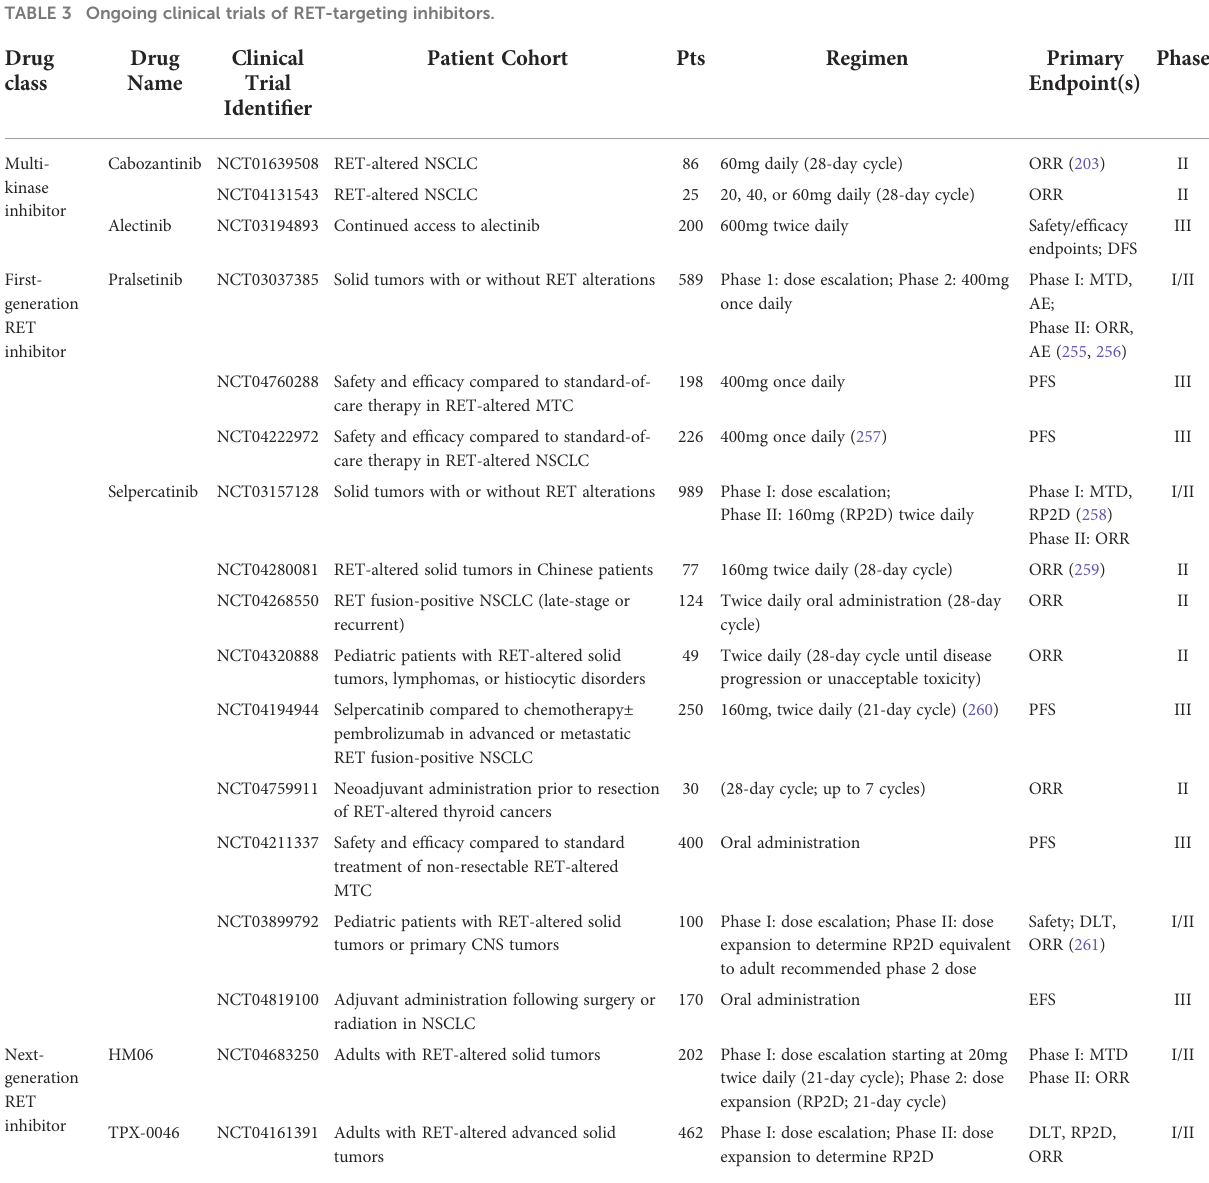
TABLE 3 Ongoing clinical trials of RET-targeting